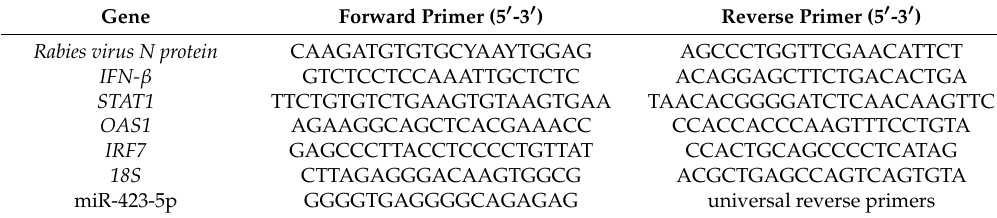
Table 1. List of primers used for quantitative reverse transcriptase PCR. Gene Rabies virus N